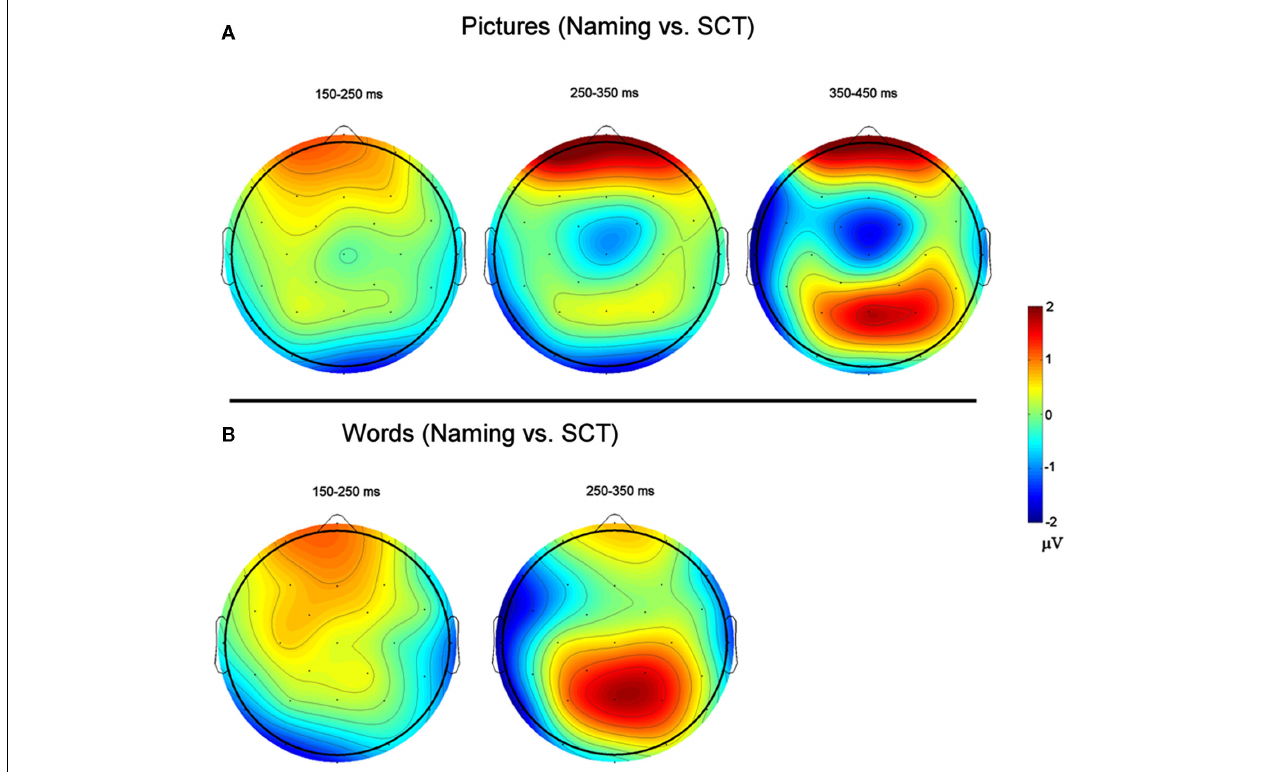
FIGURE 6 |Voltage Maps based on difference waves calculated by subtracting ERPs recorded to items during the semantic categorization